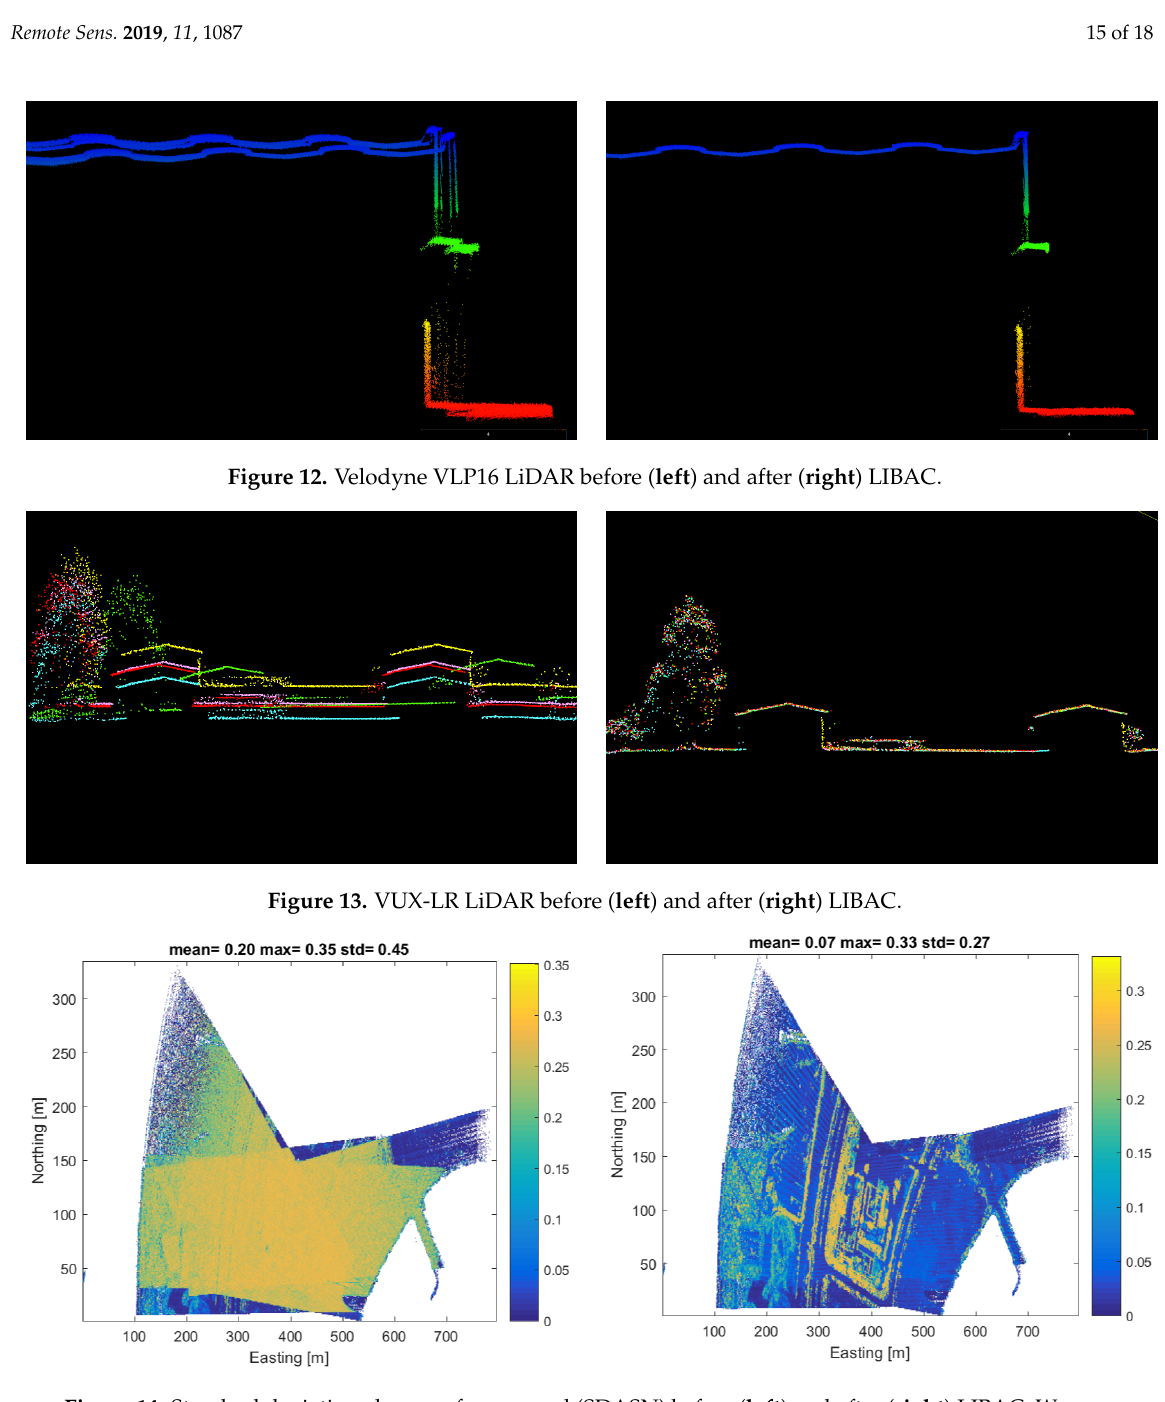
Figure 14. Standard deviation along surface normal (SDASN) before ( left ) and after ( right ) LIBAC. We can see that LIBAC reduced the main discrepancies between overlapping strip within the calibration area. The areas indicated in yellow correspond to irregularities where the local PCA is unable to fit a correct local plane. In this figure, color represents the point cloud